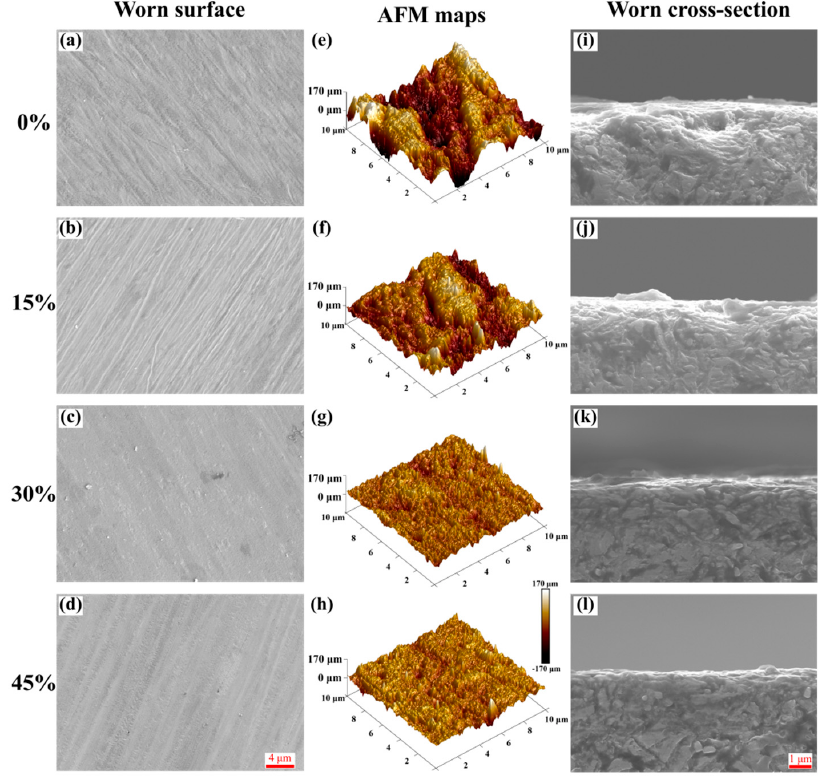
Figure 9. Morphology of RQT specimens in different hot rolling reduction after friction experiments: ( a – d ) worn surface; ( e – h ) AFM maps; ( i – l ) worn cross-section.